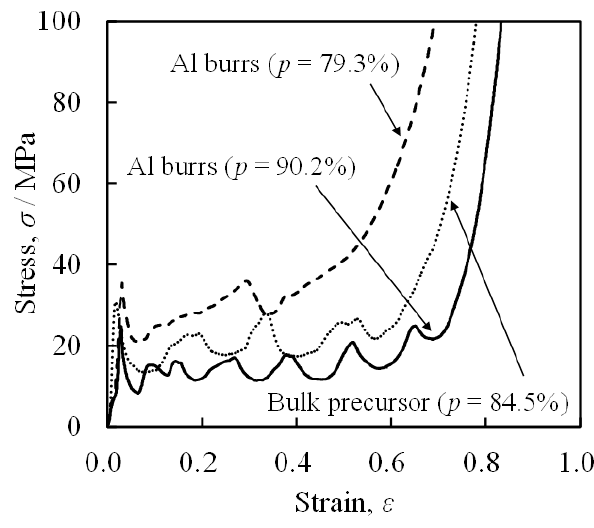
Figure 9. Stress–strain curves for the specimens in Figure 8.